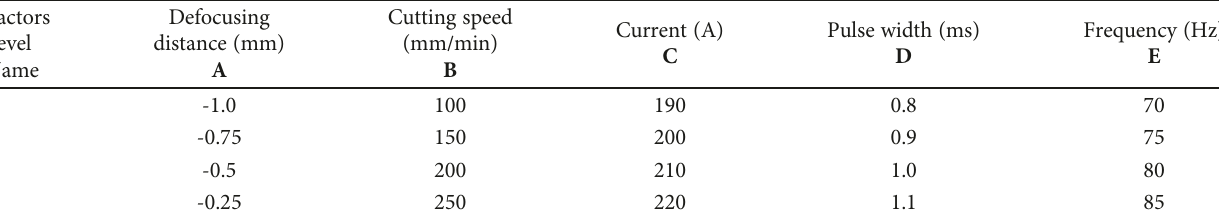
Table 2: Five-factor four-level orthogonal table.